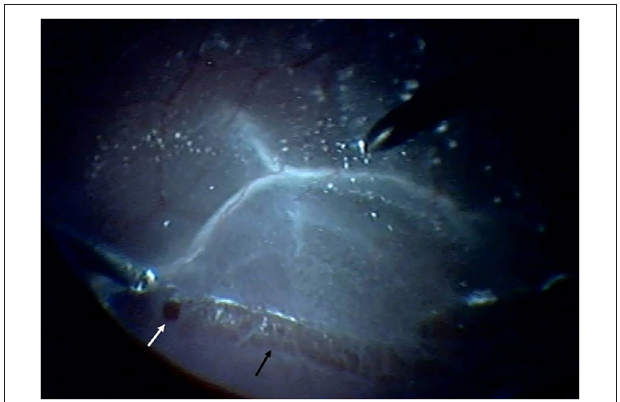
FIGURE 1 | Retinal break (white arrow) and degeneration (black arrow) were observed in the inferior site intraoperatively.